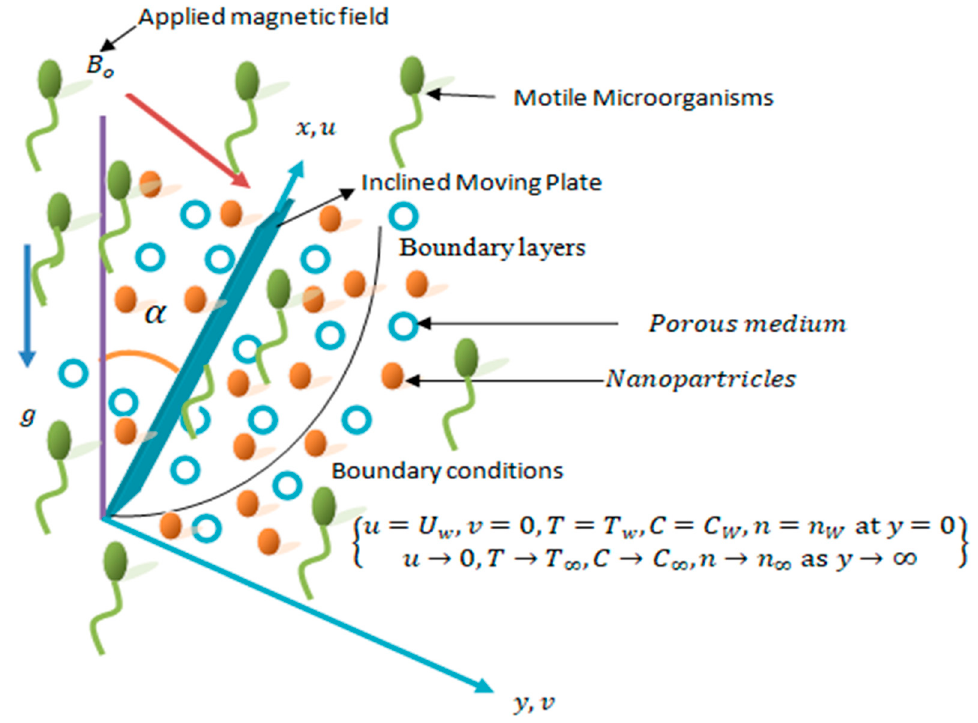
Figure 1. Flow configuration and coordinate system.